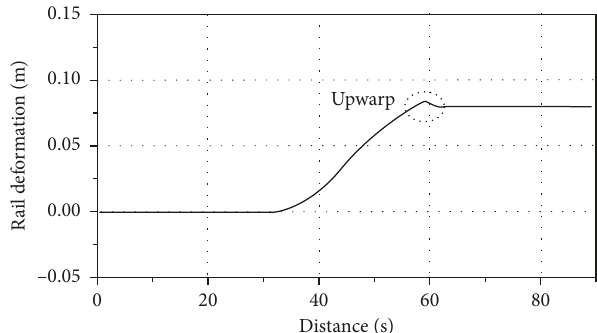
Figure 9: Deformation of rail caused by settlement.